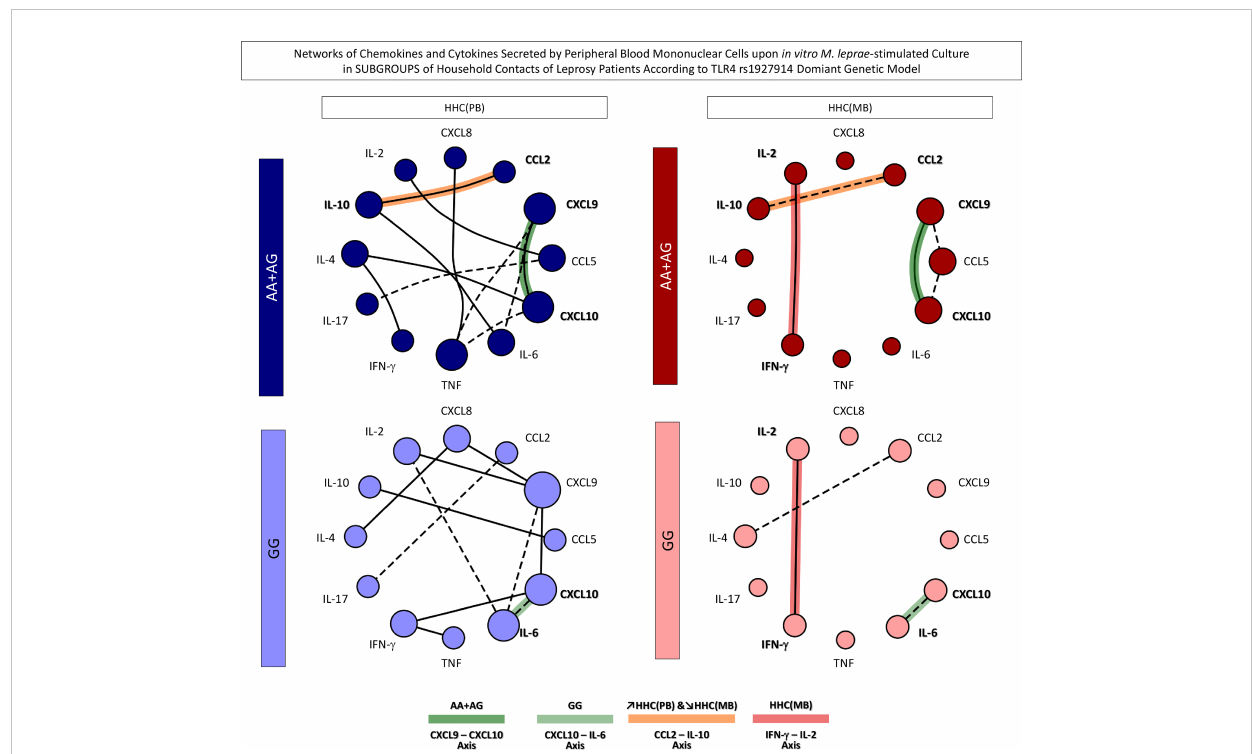
FIGURE 7 Networks of chemokines and cytokines secreted by in vitro M. leprae-stimulated peripheral blood mononuclear cells from subgroups of household contacts according to the TLR4 rs1927914 dominant genetic model. The levels of chemokines (CXCL8, CCL2, CXCL9, CCL5, CXCL10) and cytokines (IL-6, TNF, IFN- g , IL-17, IL-4, IL-10 and IL-2) were measured in the supernatant collected upon in vitro M. leprae-stimulated PBMC from household contacts of paucibacillary [HHC(PB), n =10] and multibacilary patients [HHC(MB), n = 23], further categorized according to the TLR4 rs1927914 genotype dominance model, as follows: AA+AG ( , n = 5; , n = 18, respectively) and GG ( , n = 5; , n = 5, respectively). Quantitative analysis was performed by Cytometric Beads Array (CBA) according to manufacturer instructions. The results are presented as circular layout networks with nodes representing each chemokine and cytokine as described in methods. Correlation analysis was employed to construct integrative chemokine and cytokine networks according to signi fi cant “ r ” scores at p<0.05 using Pearson and Spearman correlation tests. Connecting edges illustrate positive (continuous lines) and negative (dashed lines) strong correlations ( “ r ” scores ≥ |0.67|) between pairs of attributes. Color backgrounds were used to underscore selective edges as follows: AA+AG-selective CXCL9 – CXCL10 axis ( ), GG-selective CXCL10 – IL- 6 axis